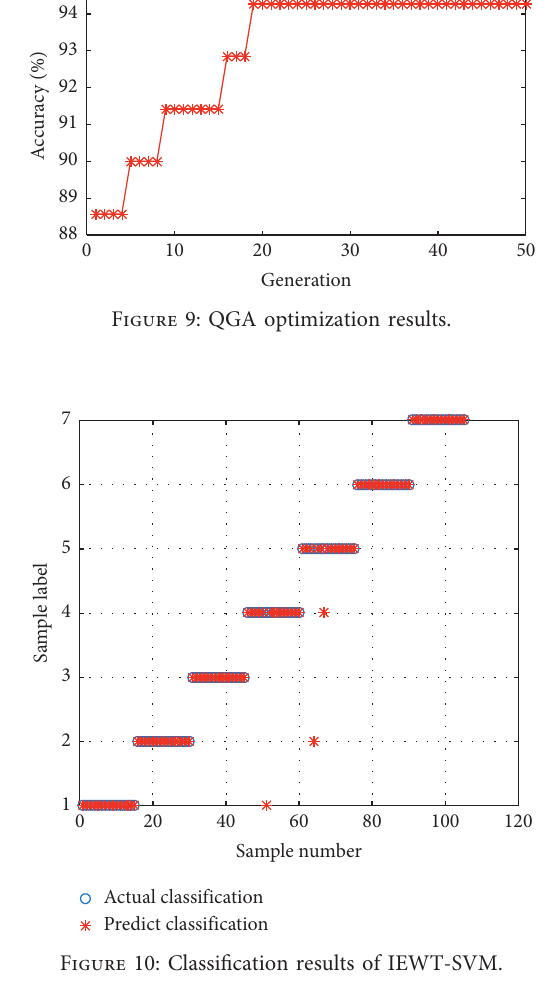
Figure 13: Prediction accuracy under different K values.